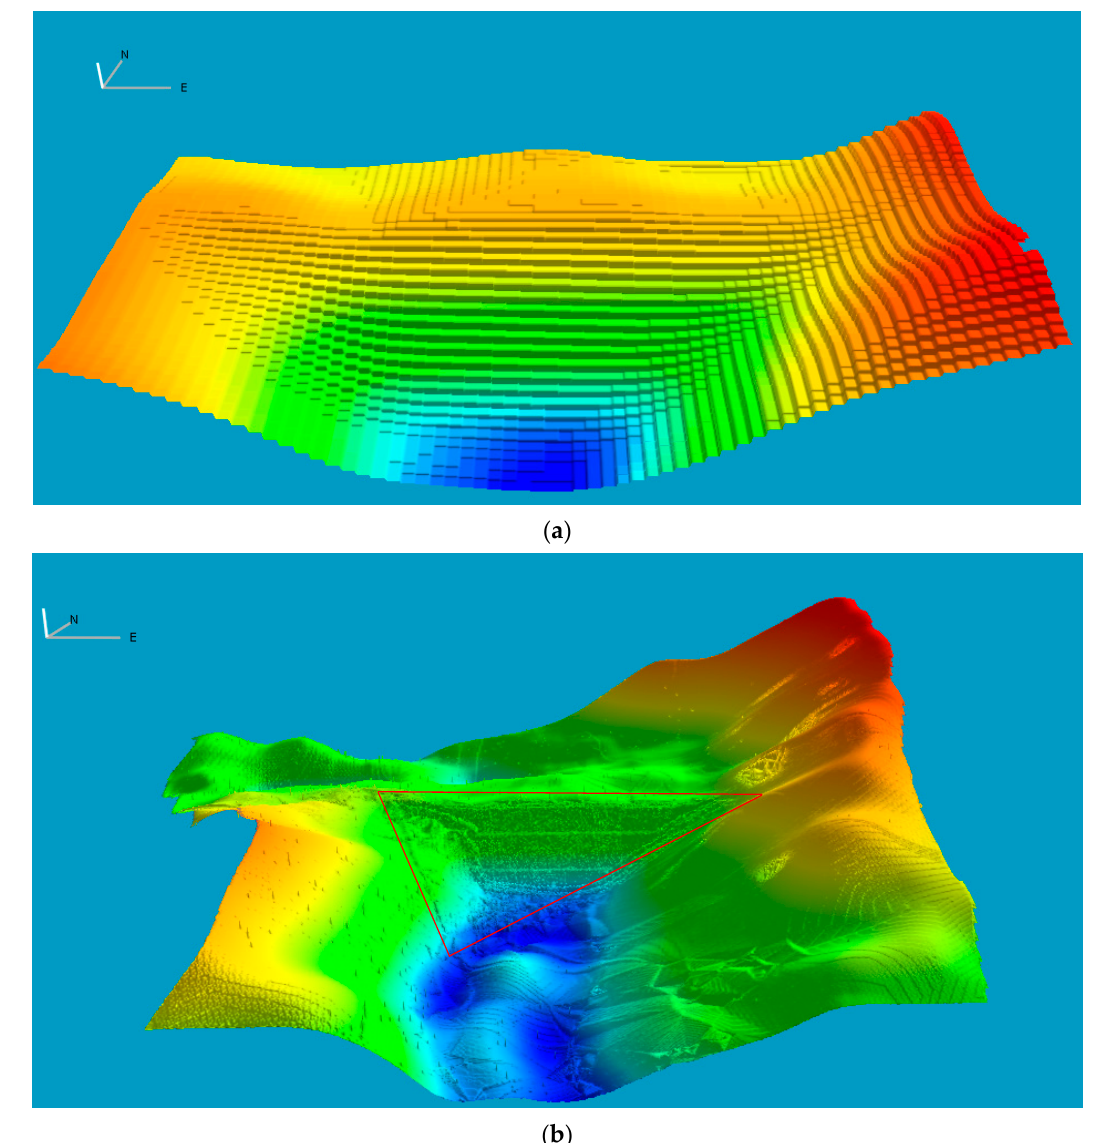
Figure 10. The TomoSAR results of the sub-test area at Zipingpu Dam of the Dujiangyan test area in China. ( a ) The TanDEM-X 12 m DEM at Dujiangyan. ( b ) The TomoSAR 1 m resolution imaging result of the COSMO-SkyMed Spotlight data at Dujiangyan, where the elevation extraction appears successful when compared to ( a ). The values retrieved over the areas covered by water were not reliable, which were not used for validation. The red triangle area is the validation area, in which the Lidar data were obtained in the fieldwork.